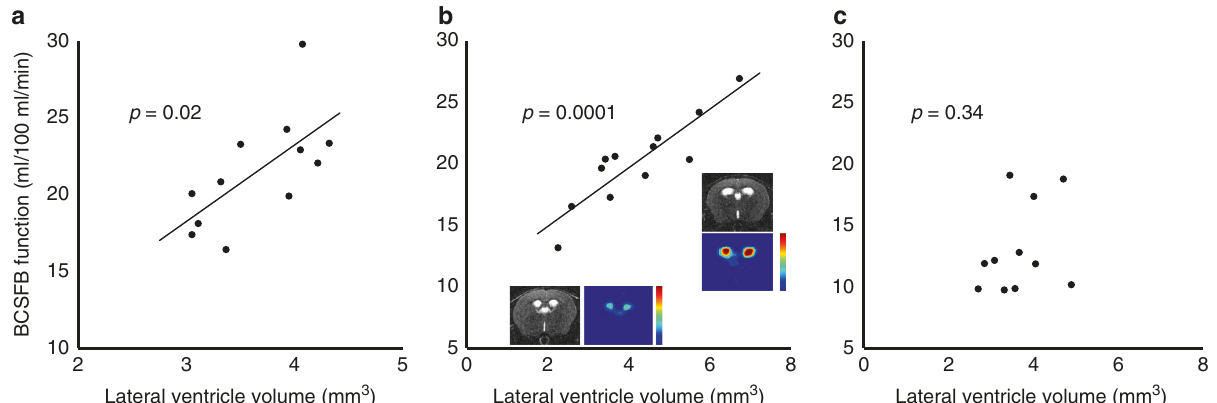
Fig. 3 Non-invasive measures of BCSFB function correlate to ventricle volume in the adult mouse brain. Scatter plots showing the estimated rate of BCSFB-mediated blood water delivery to the lateral ventricles against lateral ventricle volume for the multi-TI C57BL/6J ( n = 12] 3-month adult female cohort ( a ), the 6-month adult C57BL/6JRj ( n = 12) cohort ( b ) and the aged, 23-month C57Bl/6JRj ( n = 11) cohort ( c ). Inset: example structural and functional BCSFB-ASL images for two C57/BL6J adult mice. P values from Pearson ’ s correlation analysis, two sided.